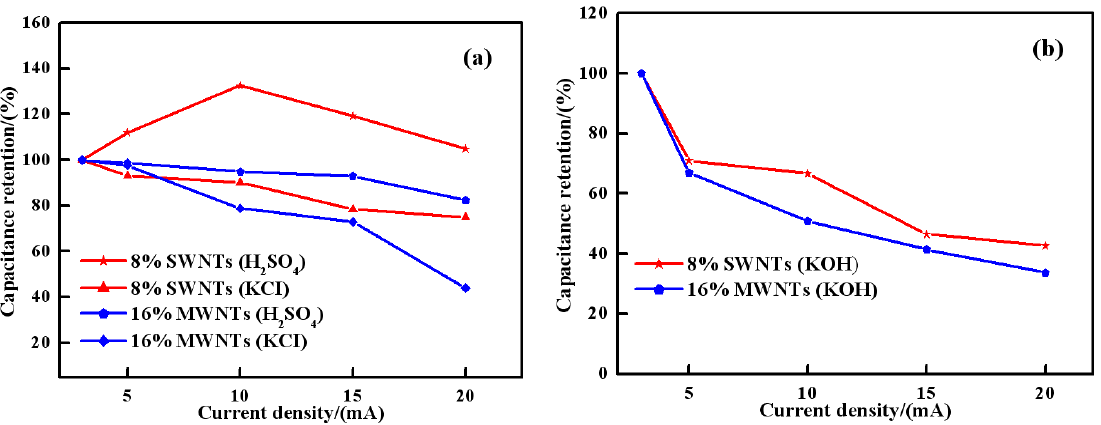
( b ) Capacitance retention of composites in 6 M